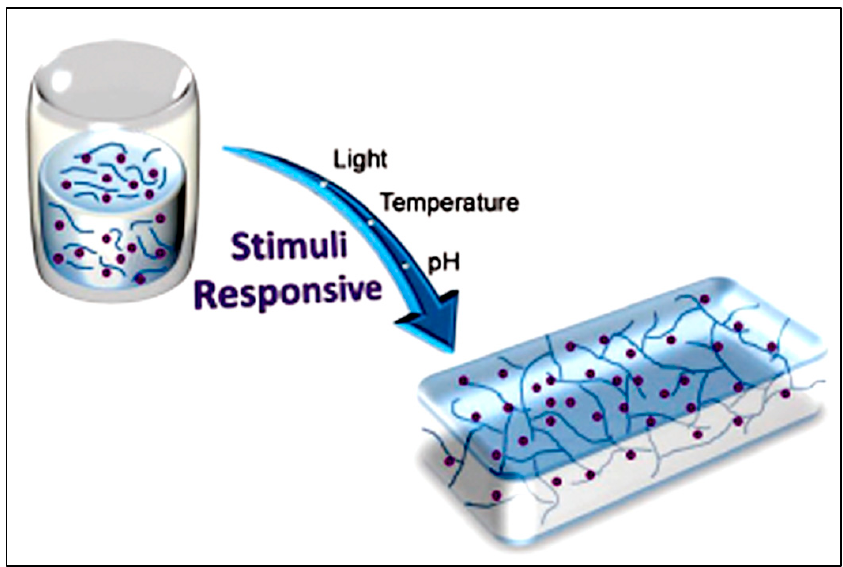
Figure 1. Schematic illustration of a stimuli-responsive hydrogel which shows a change in properties against internal or external stimuli. Reprinted with permission from Ref. [120]; Copyright 2013, De Gruyter.